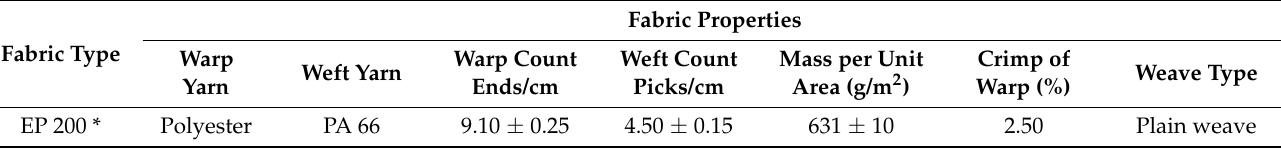
Table 1. Table 1. Properties of dipped woven fabric Table 1. Properties of dipped woven fabric sample.